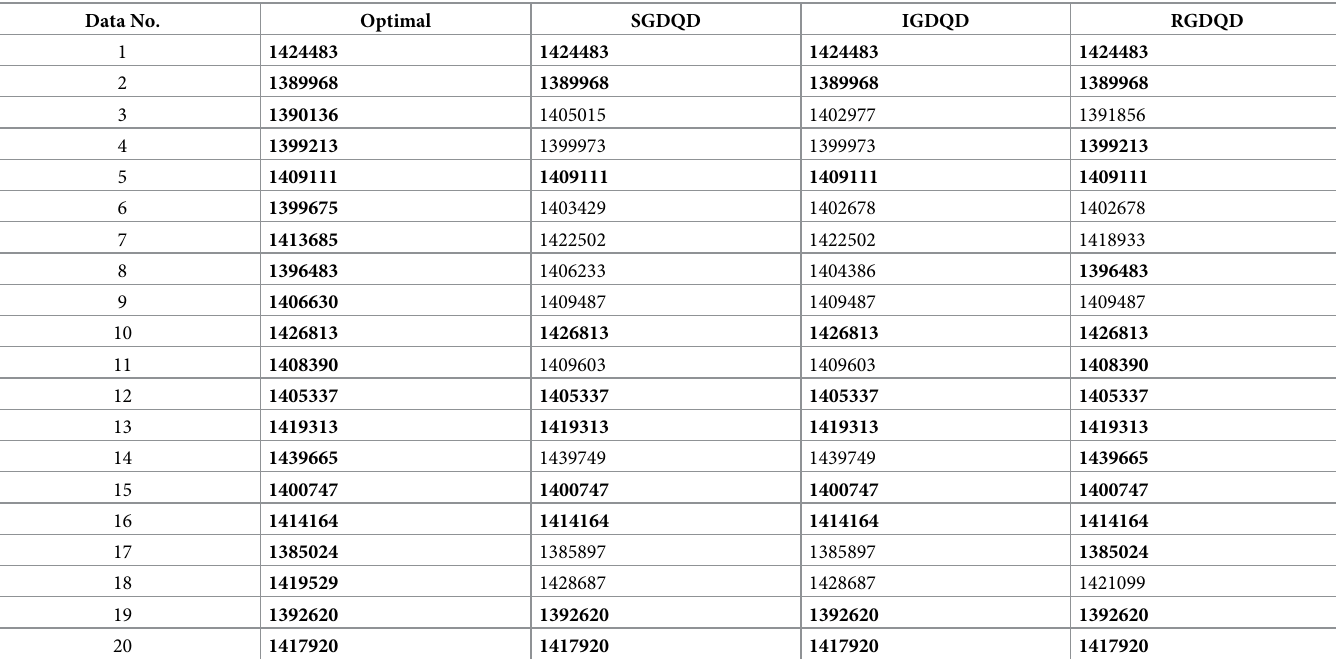
Table 10. Solutions for Q = 150000. Data No.